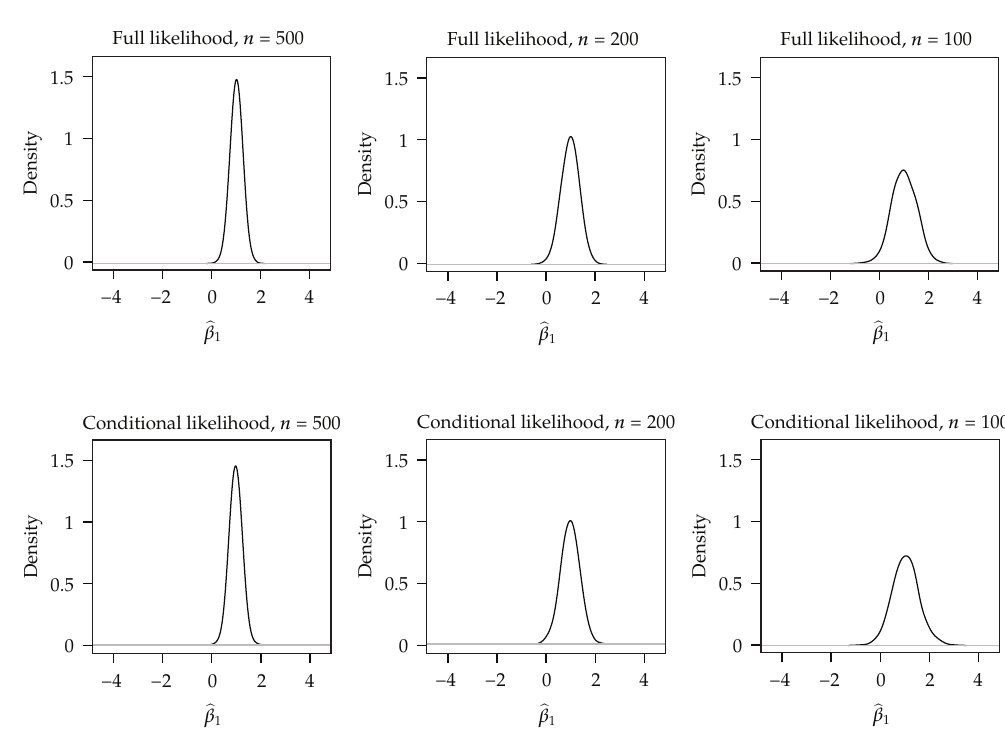
Figure 8: Sampling distributions for maximum likelihood estimates of regression coe ffi cient β 1 from 1000 replications; NPQM model fitted to normal data (cid:5) Y i ∼ Z i (cid:9) N (cid:5) 4 , 4 (cid:6)(cid:6)